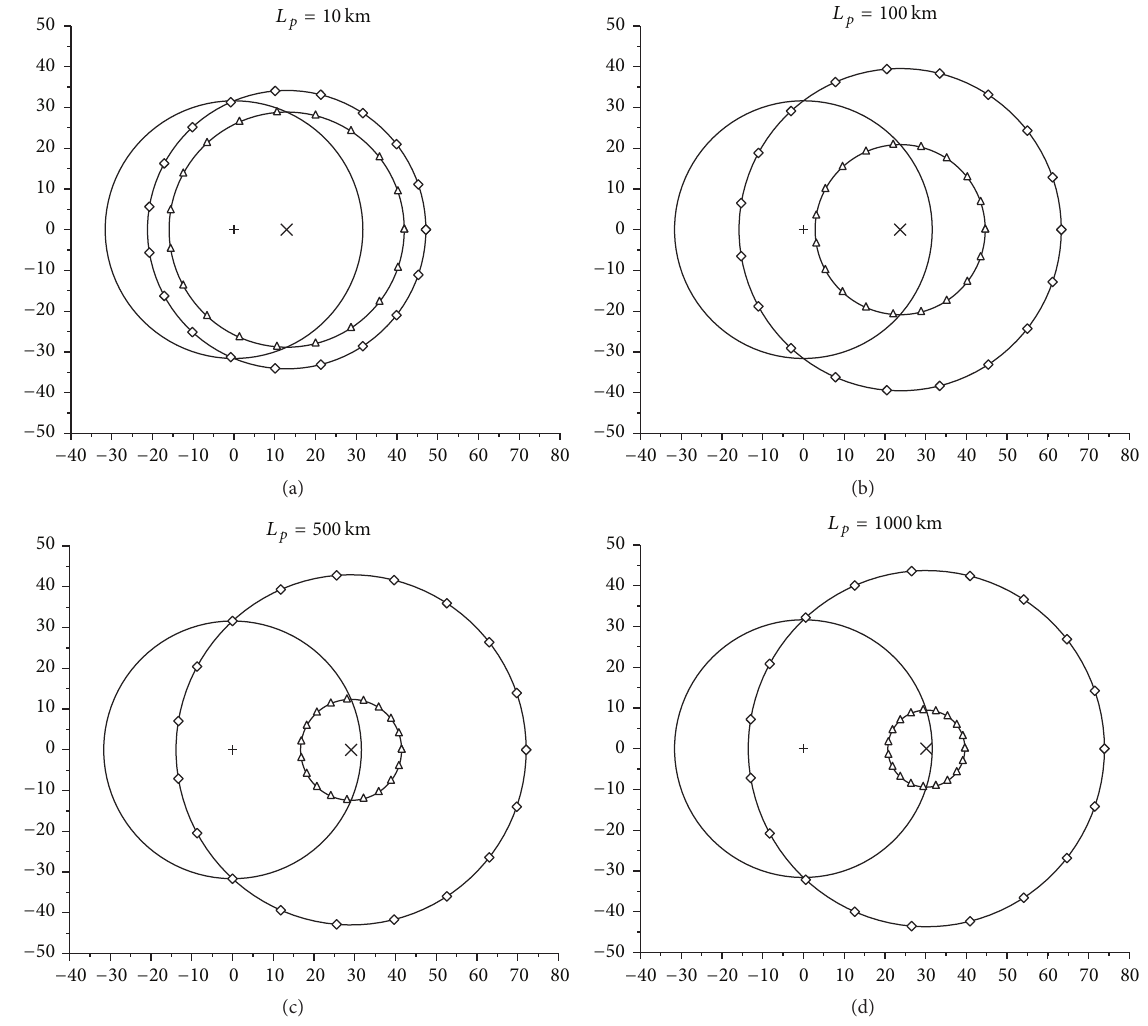
Figure 10: Illustration of the hyperspheres that contain the typical samples of the prior and a posteriori Gaussian distributions valid for the EnKF and the PF in the Gaussian setting, where + denotes the background X 𝑏 𝑞 , × denotes the analysis state X 𝑎 𝑞 , the circle without mark denotes the background distribution, the circle with triangle marks denotes the analysis distribution, and the circle with diamond marks is centered on the analysis state with a radius of the typical distance between the analysis state and the background samples. These hyperspheres are reproduced for the various length-scale parameters (a) 𝐿 𝑝 = 10 km, (b) 𝐿 𝑝 = 100 km, (c) 𝐿 𝑝 = 500 km, and (d) 𝐿 𝑝 = 1000 km, for the dimension set to 𝑛 = 1000